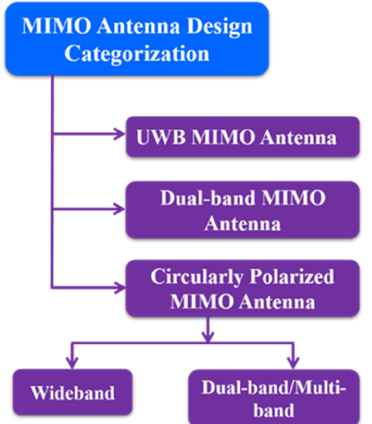
Figure 1. Categorization of MIMO antenna